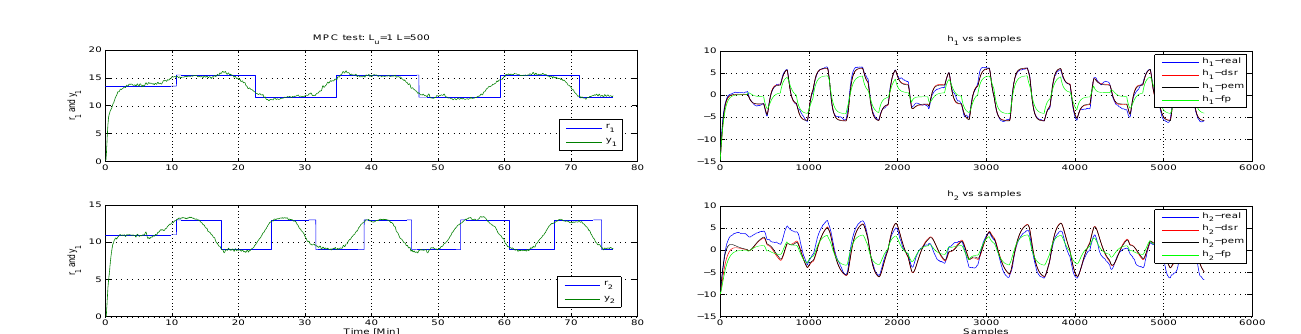
Figure 3: Practical run of the quadruple tank process as in Sec. 7, and the non-minimum phase case in Example 6.1 with MPC control with integral action. A control horizon L u = 1 and the algorithm in Sec. 4.